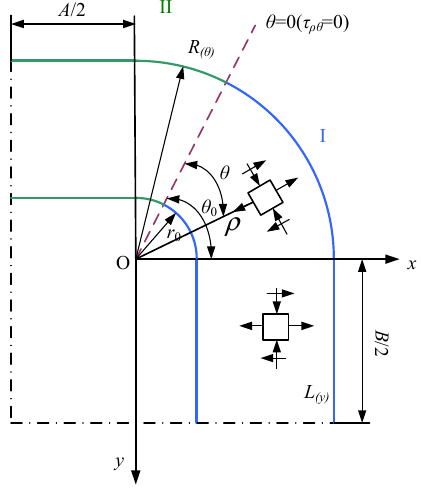
Figure 1. Schematic illustration of box-shaped part flange area.